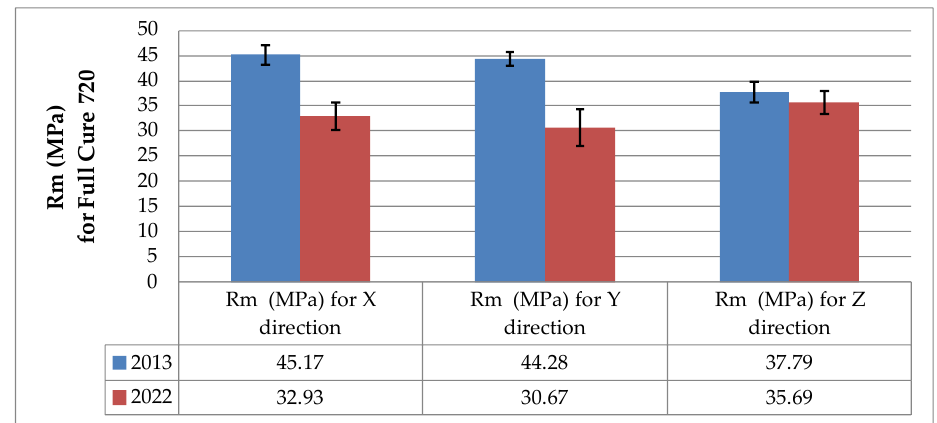
Figure 4. Tensile strength R m of the as-printed (December 2013) and naturally aged (July 2022) specimens based on FullCure 720 resin.